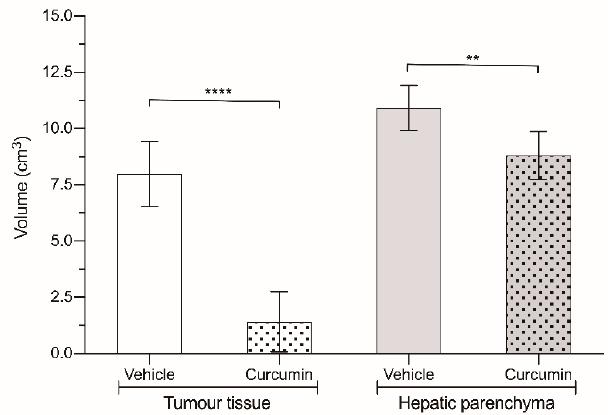
Figure 3. Volume of liver (grey) and tumor (white) tissue in animals treated with 200 mg/kg curcumin (dotted bars) and in animals treated with vehicle (solid bars). Results are expressed as mean and standard deviation (SD) from a single replicate (10 animals per group) and statistically analyzed by two-tailed t-test. Asterisks indicate statistical significance: **: p < 0.01; **** p < 0.0001.